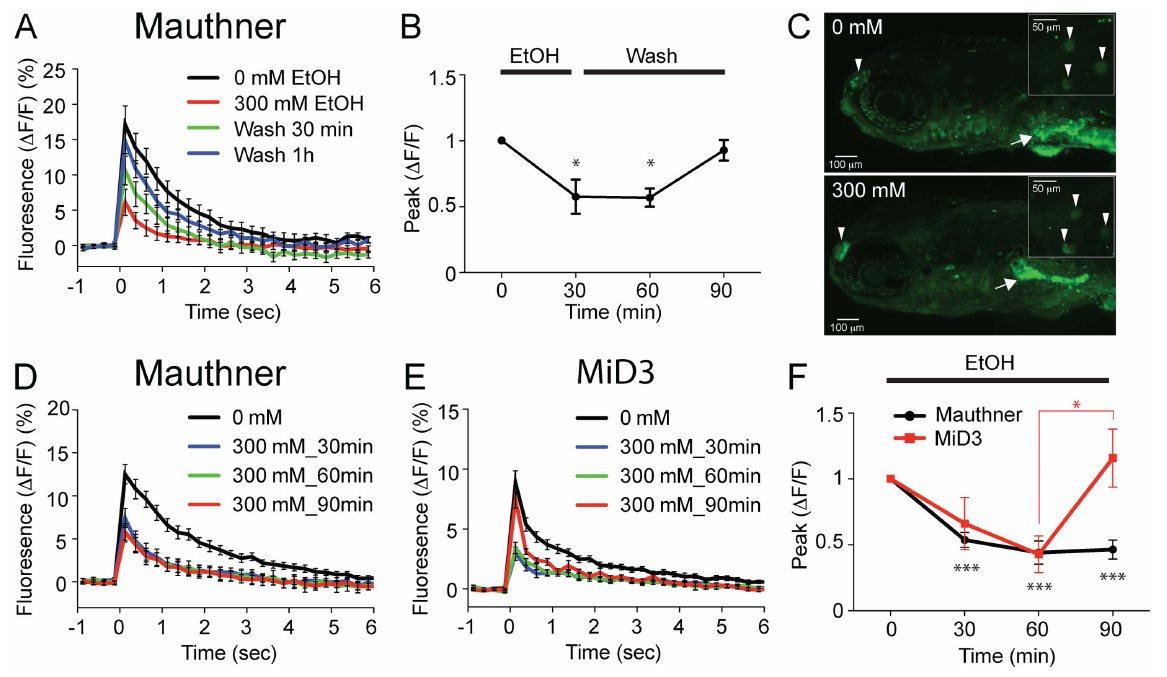
Figure 4. Recovery and adaptation of neuronal activity in 300 mM ethanol. Fluorescence intensities of Mauthner neurons and MiD3 neurons were measured in response to sound/vibration stimuli. Sectioned larvae were either washed after 30 min incubation of 300 mM ethanol (A) or bathed continuously in 300 mM ethanol (D, E). Black, red, green and blue traces correspond to 0, 30, 60 and 90 min, respectively. The peaks of D F/ F normalized to 0 min were plotted against time in B (for A) and F (for D, E) (*P , 0.05, ***P , 0.001 versus 0 min). Five Mauthner neurons and six MiD3 neurons were measured. Stimuli were applied and calcium transients were elicited at each concentration 2–5 times. The numbers of samplings are shown in parentheses. (C) AO staining in 0 mM (top) and 300 mM (bottom) ethanol are shown. Apoptosis in olfactory organs is marked with arrowheads. Apoptosis of neuromasts, located on the body surface, are shown with arrowheads in insets. Nonspecific signals are observed in the gut